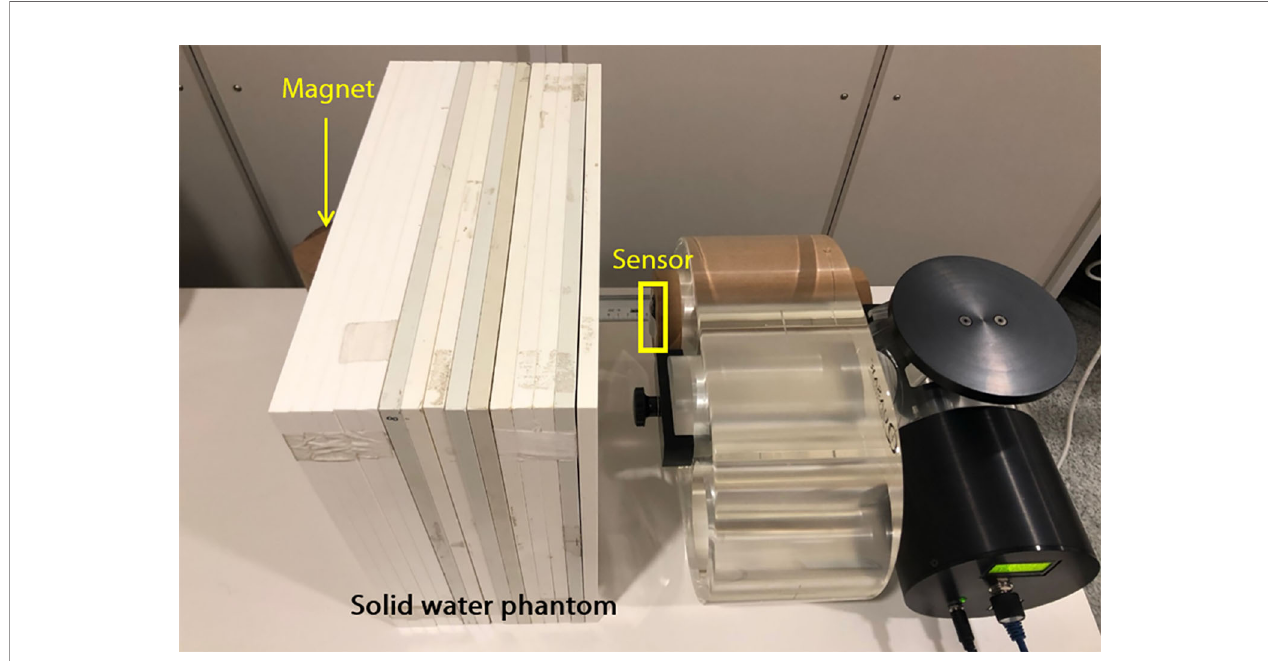
FIGURE 4 | The experimental setup for evaluation of signals according to the absence and presence of material between the sensor and